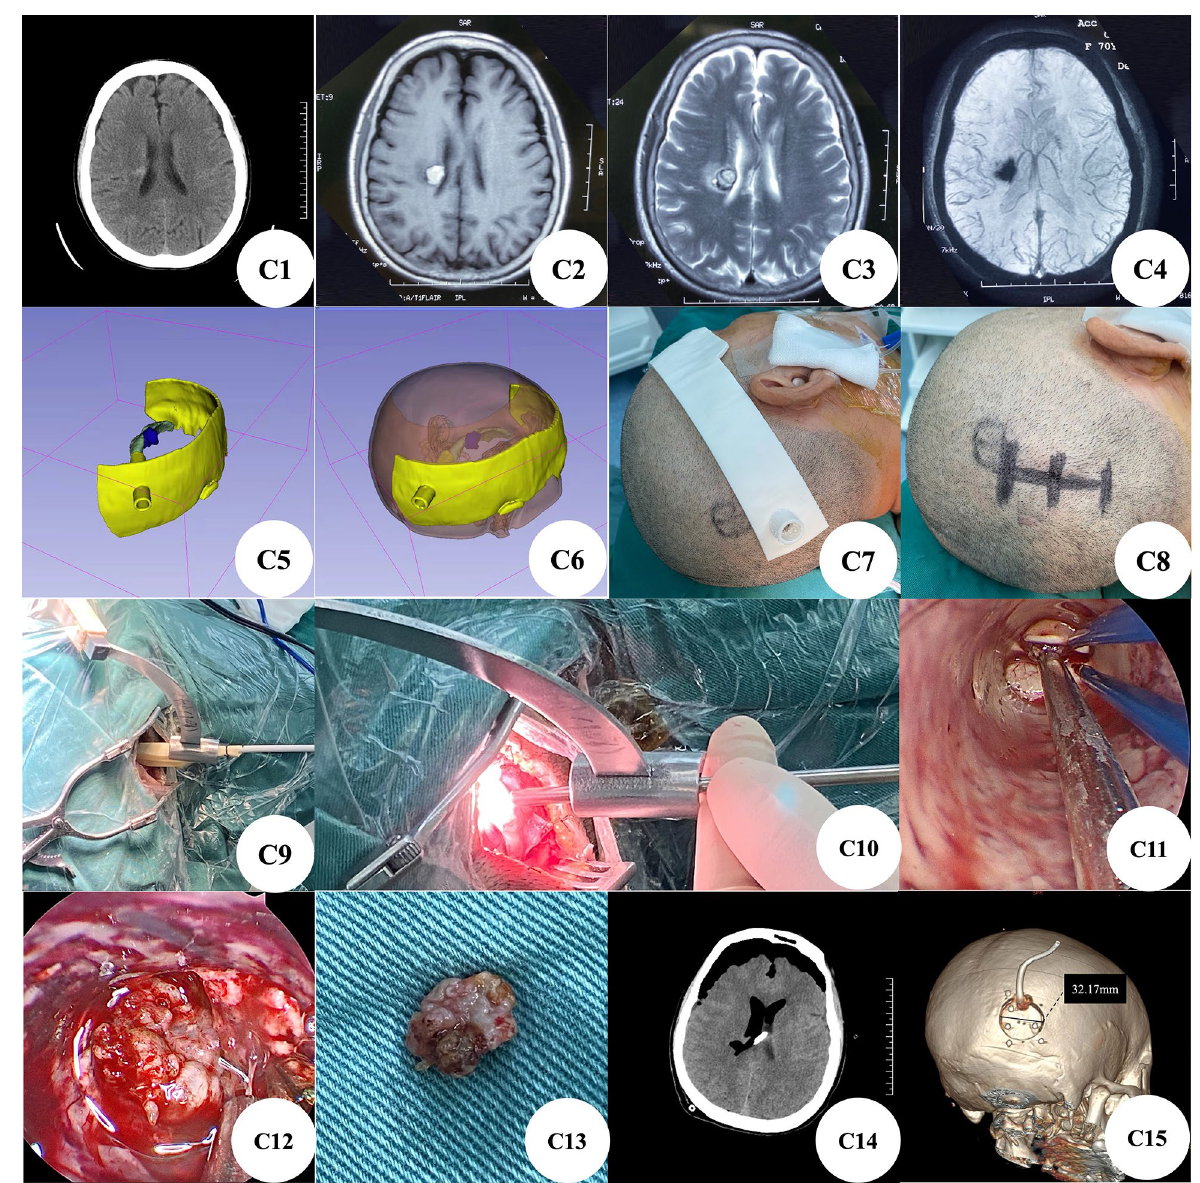
Figure 4. ( C1 ): Preoperative brain CT showed high-density lesions in the proximal ventricle of the right basal ganglia; ( C2 – C4 ): Preoperative brain MRI showed lesions in the proximal ventricle of the right basal ganglia; ( C5 – C6 ): 3D-Slicer reconstructed the relationship between the lesion and lateral ventricle, and positioned the three-dimensional image of the guide plate; ( C7 ): 3D printing positioning guide; ( C8 ): Straight surgical incision designed according to the printed positioning guide; ( C9 – C10 ): Metal 3D guide plate for intraoperative positioning; ( C11 – C13 ): Complete resection of lesions assisted by transcranial neuroendoscopic; ( C14 ): Postoperative brain CT showed that the focus was removed completely; ( C15 ): The three-dimensional reconstruction of the skull showed that the size of the bone window was about 3.2